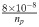
Estimated demographic history of Daphnia pulex.Demographic history estimated by eSMC on six individuals of D. pulex accounting for egg-banks (β is a variable and σ = 0). Different assumptions concerning the number of parthenogenetic cycles before the production of the dormant egg are made: Five cycles (pink), two cycles (red) and no parthenogenesis (dark red). A subset of demographic history estimated by PSMC’ are ploted in organge. Mutation and recombination rates are respectively set to 4.33 × 10−9 and 8×10−8np per generation per bp, where np is the number of reproductive cycles per year, parthenogenetic and sexual.